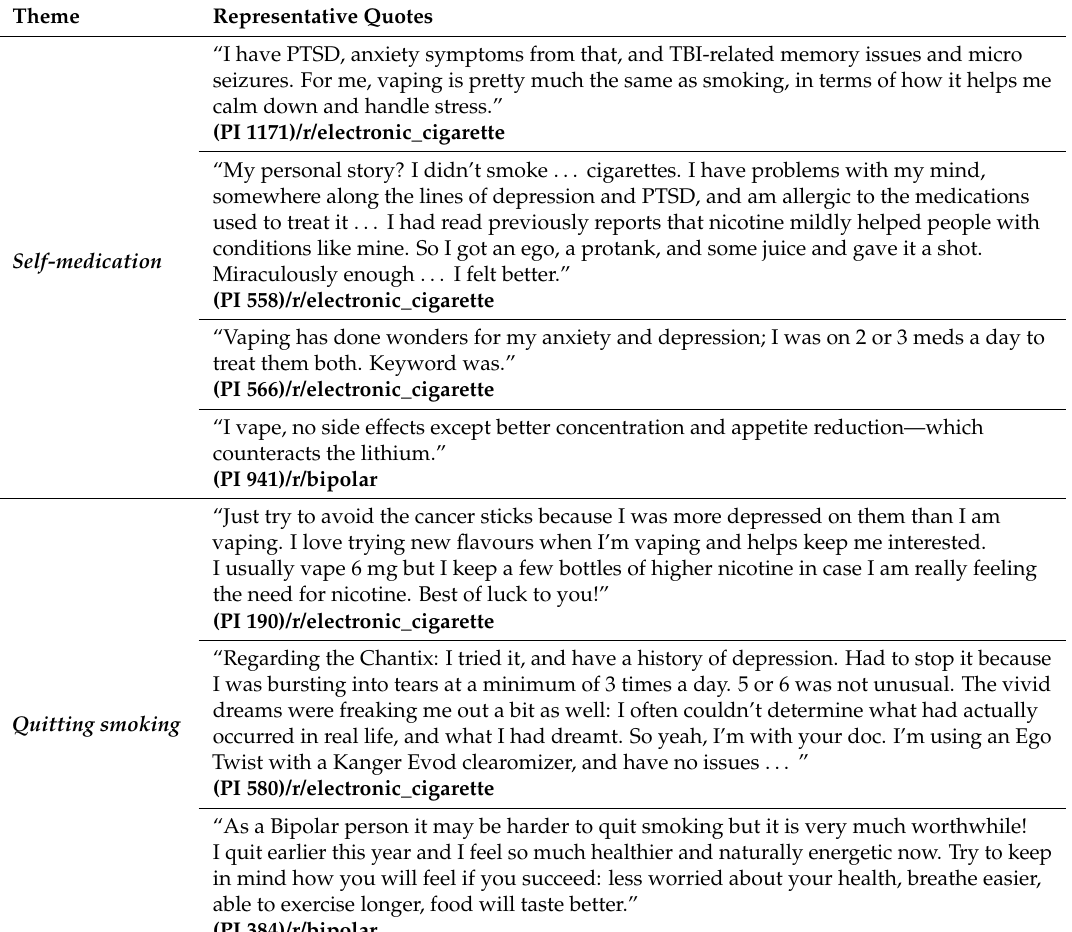
Table 2. Motivations for using